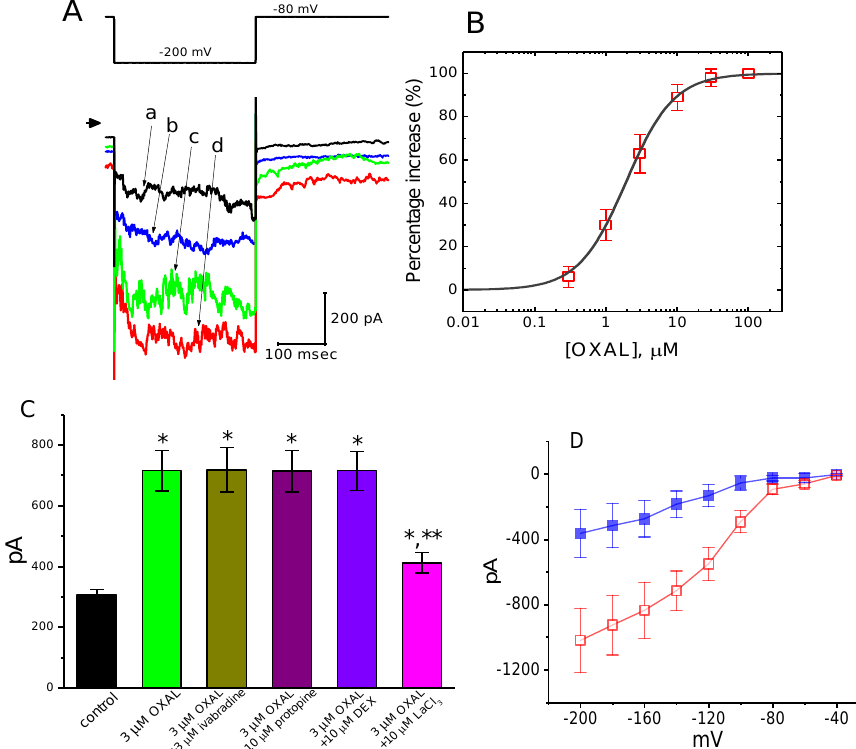
Figure 5. The stimulatory e ff ect of OXAL on membrane electroporation-induced inward current ( I MEP ) in GH 3 cells. Cells were immersed in Ca 2 + -free Tyrode’s solution and the examined cells were maintained at − 80 mV. ( A ) Representative I MEP traces elicited by membrane hyperpolarization from − 80 to − 200 mV (as indicated in the upper part). Arrowhead is zero current level; a: control; b: 1 µ M OXAL; c: 3 µ M OXAL; d: 10 µ M OXAL. ( B ) Concentration-dependent stimulation of I MEP by OXAL (mean ± SEM; n = 8 for each point). ( C ) Summary bar graph showing e ff ects of OXAL, OXAL plus ivabradine, OXAL plus protopine, OXAL plus DEX (dexmedetomidine), and OXAL plus LaCl 3 (mean ± SEM; n = 9 for each bar). Current amplitude was taken at the end of hyperpolarizing pulse from − 80 to − 200 mV. The smooth line represents least-squares fit to a Hill function detailed in Materials and Methods. * Significantly di ff erent from control ( p < 0.05) and ** significantly di ff erent from 3 µ M OXAL alone group ( p < 0.05). ( D ) Averaged I–V relationships of I MEP obtained in the absence (closed squares) and presence (open squares) of 3 µ M OXAL (mean ± SEM; n = 9 for each point). As the whole-cell mode was firmly established, the cells were maintained at − 80 mV and a family of voltage pulses ranging between − 200 and − 40 mV with a duration of 300 ms at increments of + 20-mV were applied. Current amplitude was measured at the end of each voltage